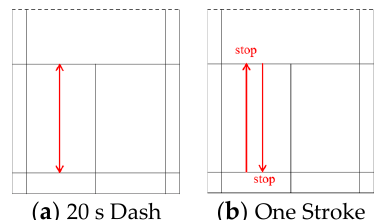
Figure 1. Two types of movement: ( a ) To dash back and forth a certain distance for 20 s; ( b ) Stops with one stroke, and five sets are executed before and after. The distance of each movement is about 4